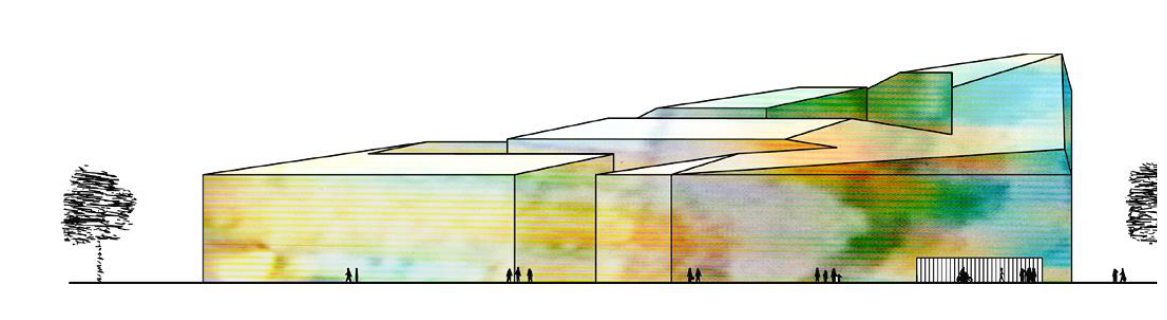
Fig. 8 Diagram of La Defense Offices with foil application ©UNStudio.